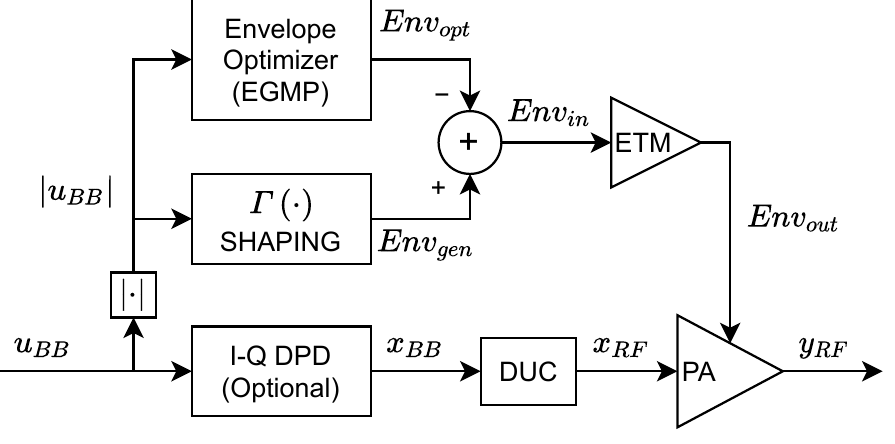
Figure 1. Block diagram of the forward path for ET PA